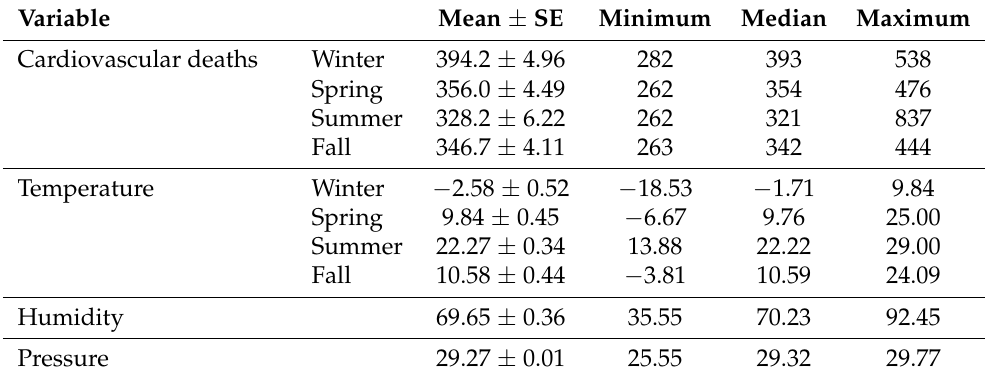
Figure 3. Mean temperature and CVD p-spline smoothed function of the unknown nonlinear relationship and its 95% confidence interval ( left ), and the boxplots of CVD deaths over the 12 months of the year ( right ). Table 1. Numerical summary of weather variables and cardiovascular deaths by season in